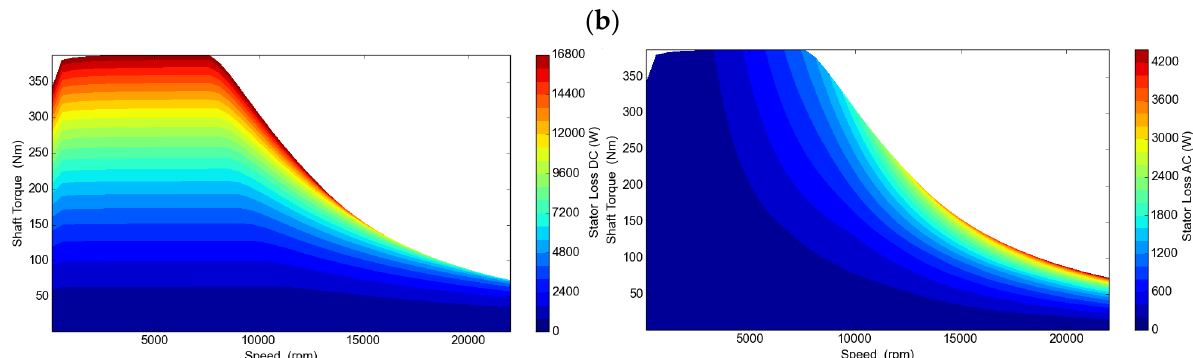
Figure 7. Maps of DC and AC joule stator losses for the three considered designs.